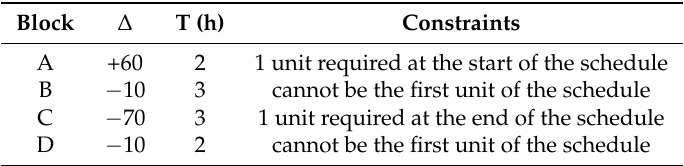
Table 3. Component details for Batch Reactor-Separator (BR-S)